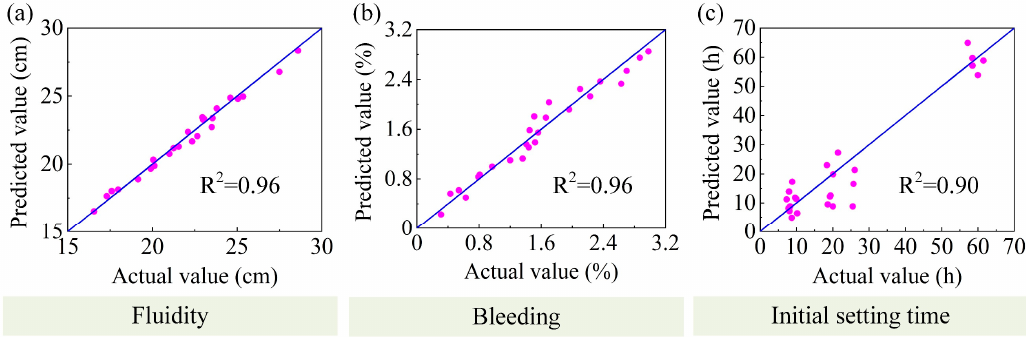
Figure 20. Performances of CS predicted models. ( a ) 7D ( b ) 14D ( c ) 28D.